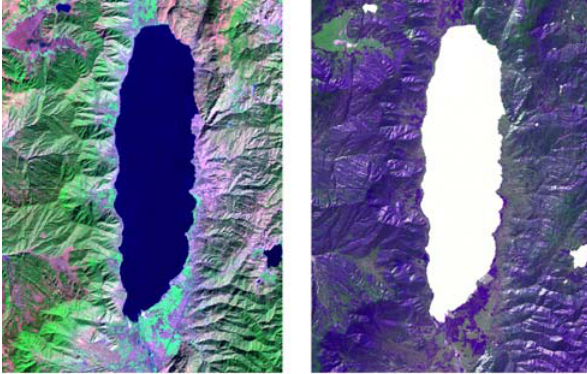
Figure 6 Swamp wetland around the lake enhanced results